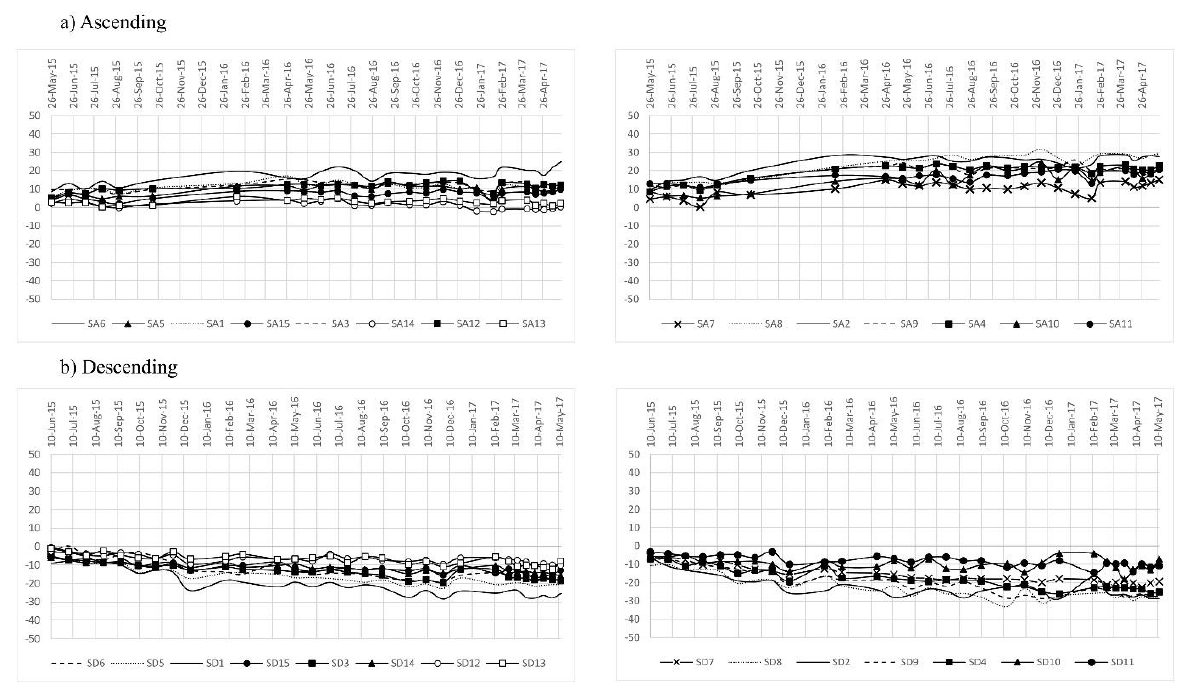
Figure 21. Cumulative 2-year LOS displacements at the Barnard landslide by ( a ) Sentinel Ascending and ( b ) Sentinel Descending. The calculated horizontal components of R on the Barnard landslide are shown in Figure 22. The magnitude of the horizontal displacements is between 2 and 18 mm/year, with the maximum horizontal displacement at sector 2, in the center of the landslide. The